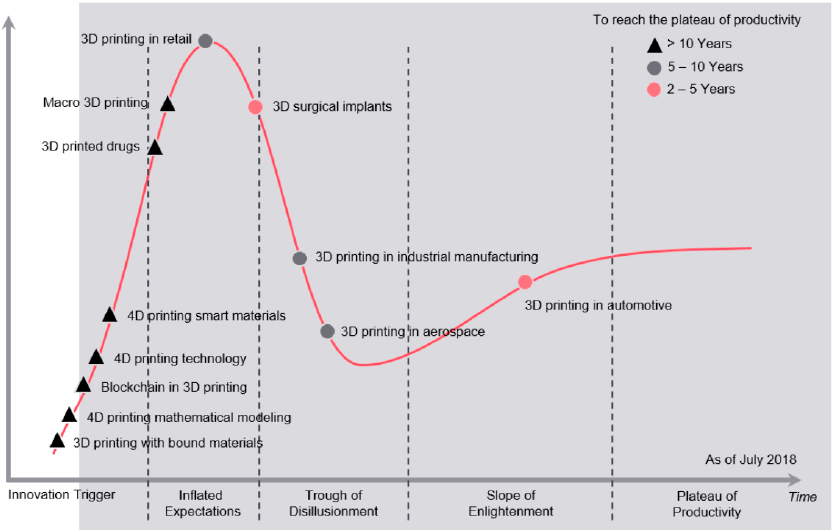
Figure 21. Gartner Hype Cycle of 3D and 4D printing technologies. Figure reproduced from FutureBridge Analysis [211].